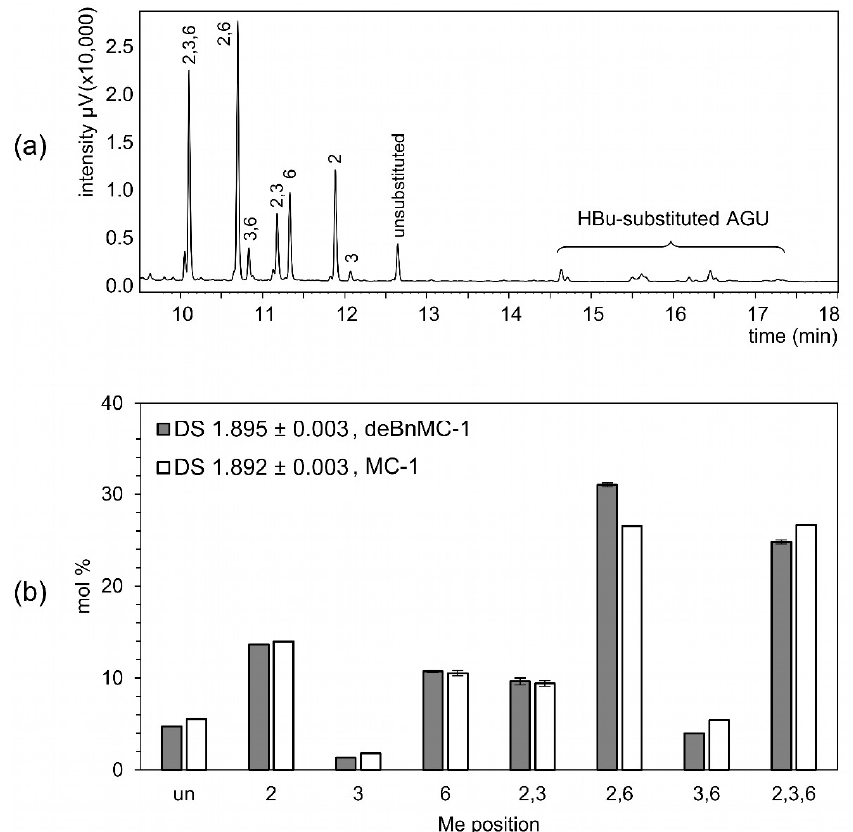
Figure 3. ( a ) The GLC-FID chromatogram of deBnMC-1 (Method-1, Table 1). Numbers on the peaks show the methyl substitution position on AGU; ( b ) Evaluated methyl substitution pattern of deBnMC-1 and MC-1 based on monomer analysis of alditol acetates by GLC-FID. The MC-1 was analyzed after perethylation, while MC-1 after benzylation and debenzylation was analyzed without perethylation. For details, refer to the Materials and Methods Section 2.6.1.